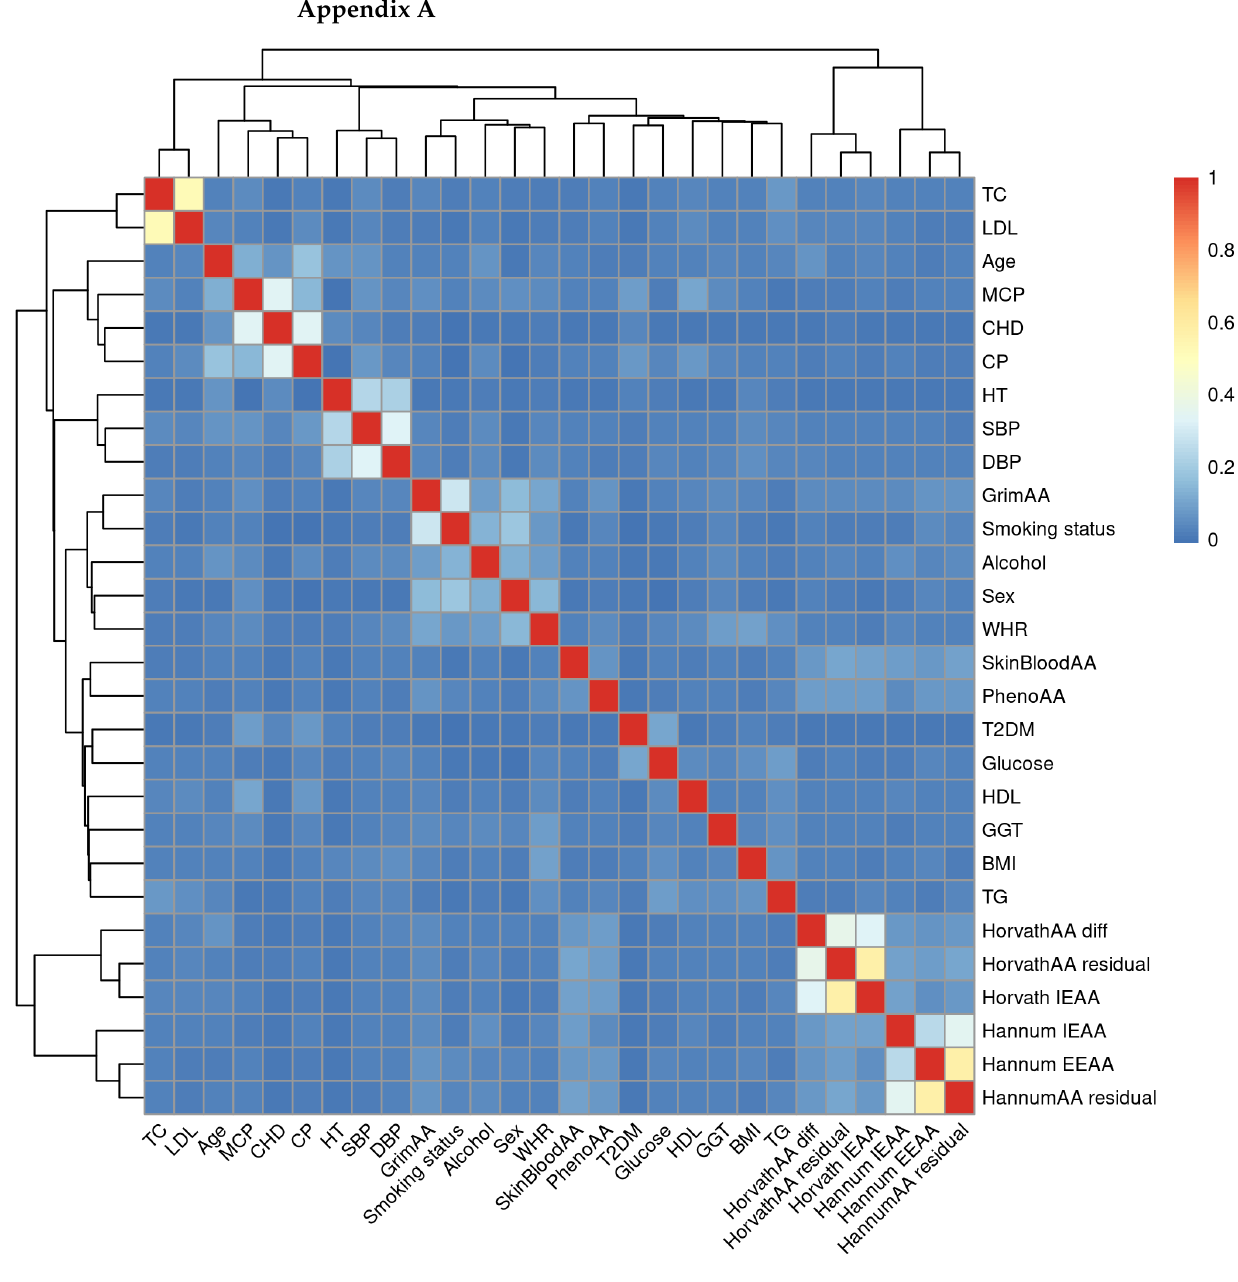
Figure A1. Normalised mutual information